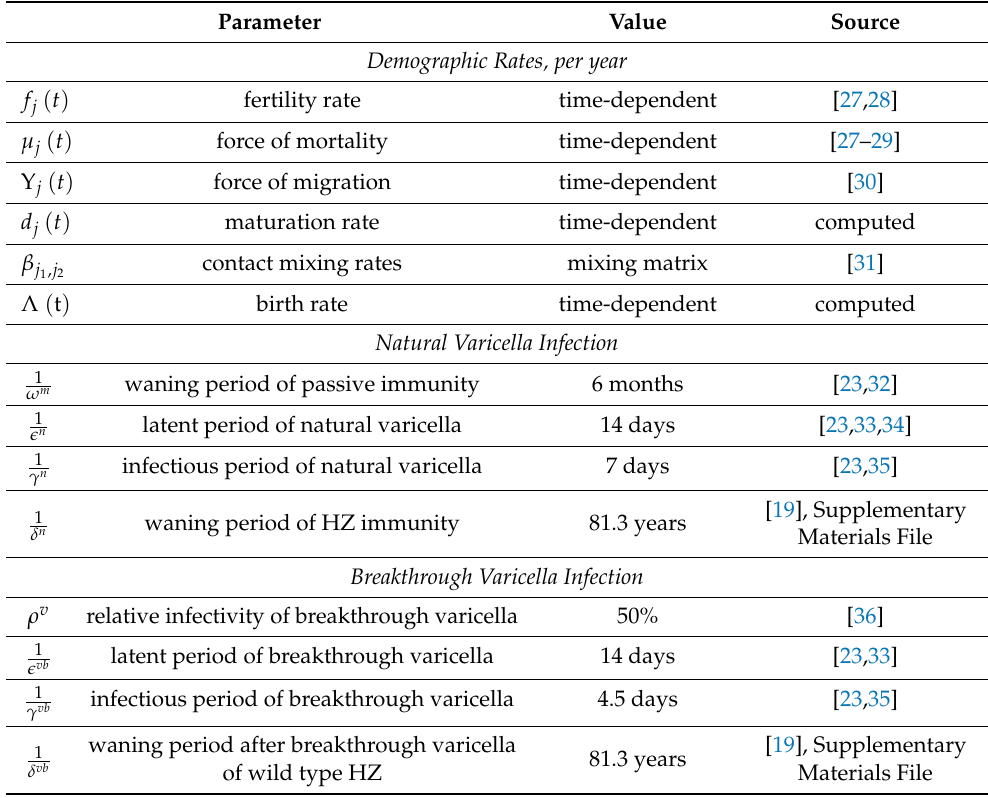
Table 1. Demographic and epidemiological